Question: In one sentence, what is this figure communicating?
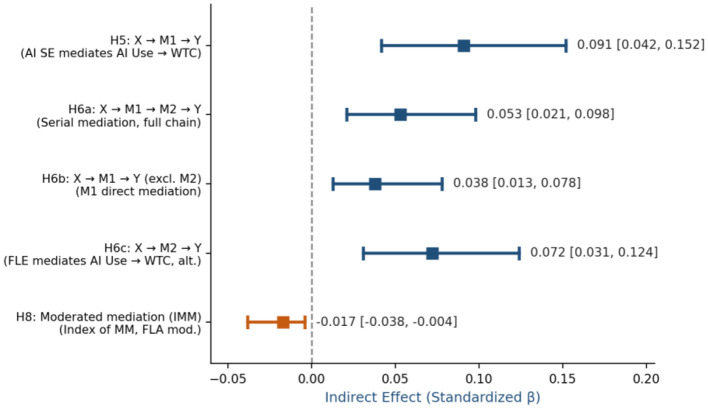
Answer: Forest plot of bootstrapped indirect and moderated mediation effects with 95% confidence intervals (10,000 replications). IMM, index of moderated mediation. Bars not crossing zero indicate significant effects. N = 420.